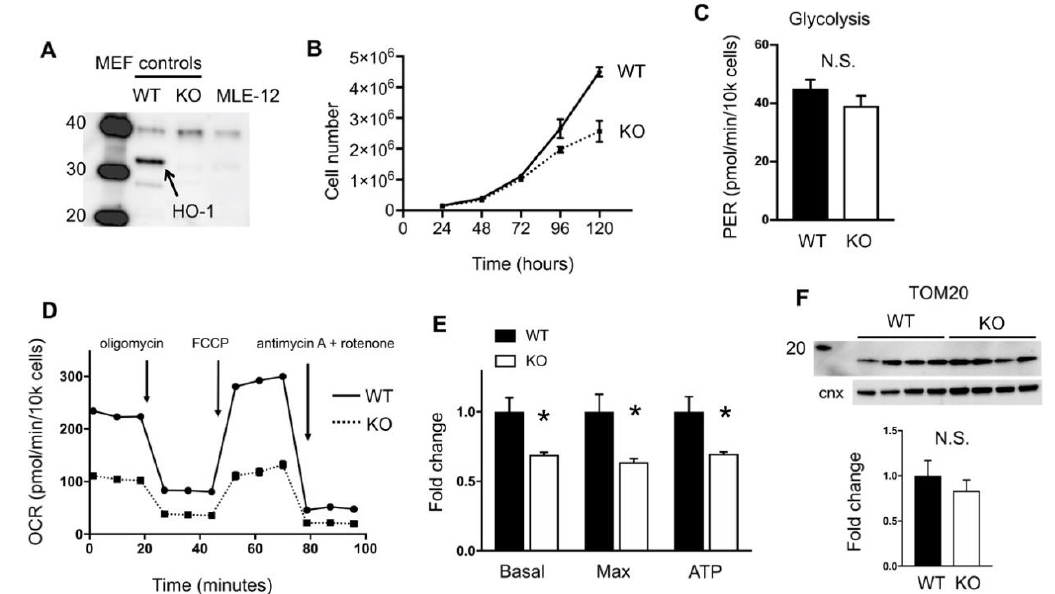
Figure 1. Heme oxygenase (HO-1) knockout cells have impaired growth and decreased mitochondrial respiration. ( A ), Western blot showing deletion of HO-1 in MLE-12 cells (far right). Positive (wild-type (WT)) and negative (knockout (KO)) controls from mouse embryonic fibroblasts (MEF) [23] were included. ( B ), Growth curves of WT and KO MLE-12 cells. ( C ), Glycolysis was measured in the Seahorse. PER, proton e ffl ux rate. ( D ), Representative trace of the mitochondrial stress test measured in the Seahorse. OCR, oxygen consumption rate. Arrows indicate injection time of drugs. ( E ), Basal and maximal respiration, and ATP production were determined with the mitochondrial stress test. ( F ), Western blot of TOM20 (top) normalized to calnexin loading control (bottom). Molecular weight of 20 kDa is shown. * p < 0.05 vs. WT. Error bars are standard error of the mean (SEM).